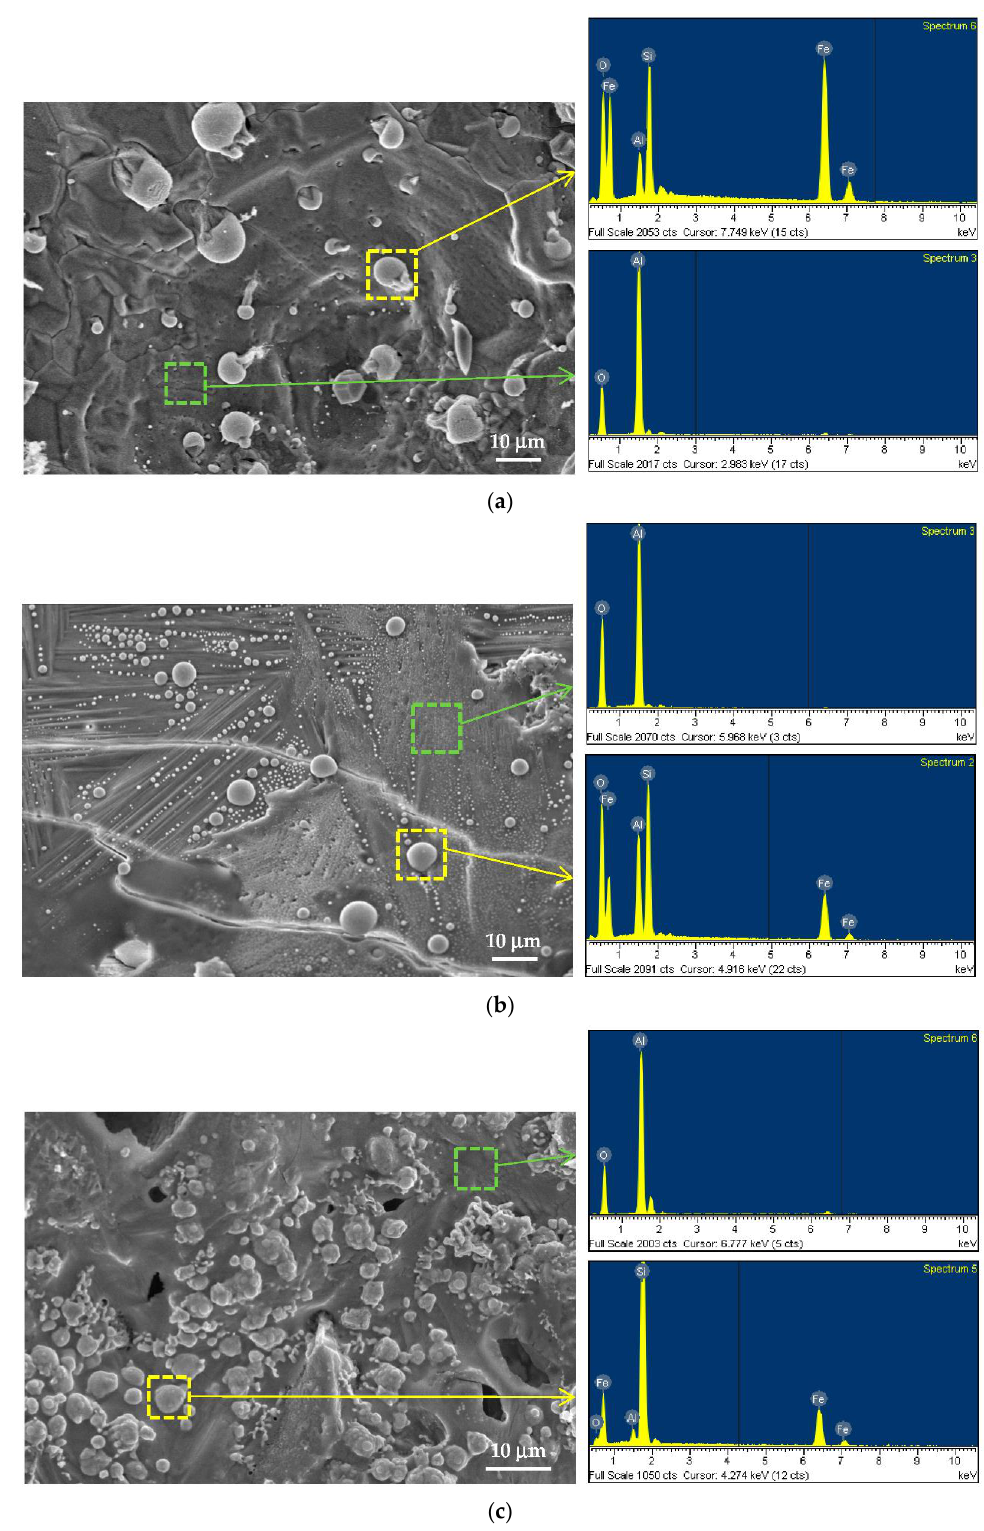
Figure 7. SEM micrographs and EDS spectra of SHS products of ( a ) Reaction (1) of Fe-25% Si, ( b ) Reaction (2) of Fe-50% Si, and ( c ) Reaction (2) of Fe-70.5% Si.